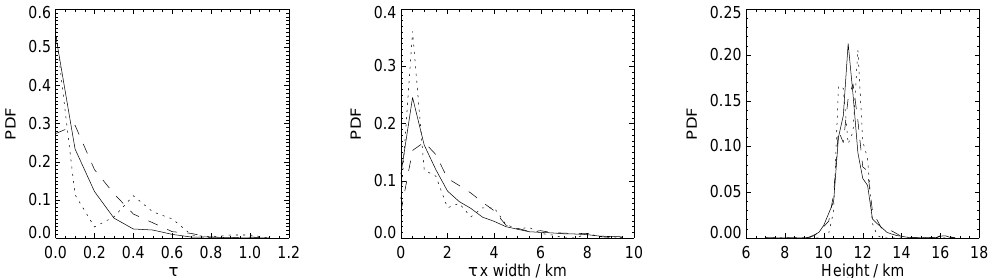
Figure 8. Histograms of the optical depth, τ (left), the product of τ and width (centre) and the height above sea level (right) for different contrail ages. Solid line: younger than 30 min; dashed: 3 to 5h; dotted: longer than 8h.